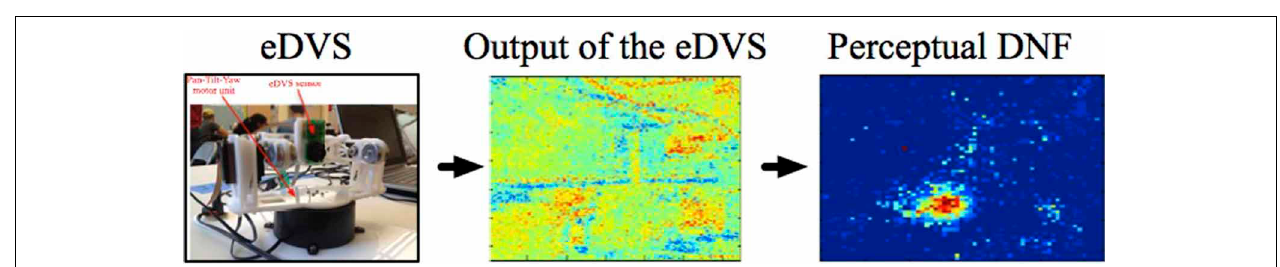
in the color DNF over the hue value of the named color. This activity peak is projected onto the 2D perceptual DNF as a subthreshold activity ridge, which overlaps with the camera input for the green object. The resulting activity peak in the 2D DNF provides input to the spatial DNF, which, in its turn, sets an attractor for the motor dynamics. The latter drives the motor system of the agent, initiating an overt action.